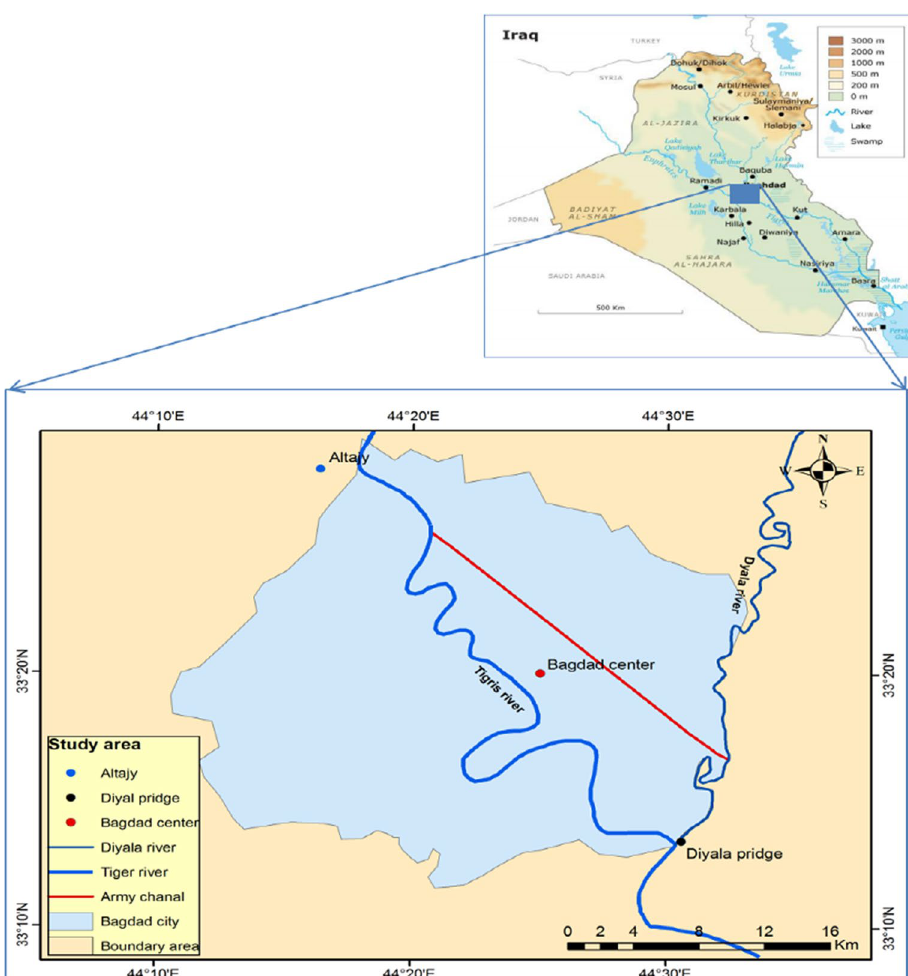
Fig. 1 Location map of